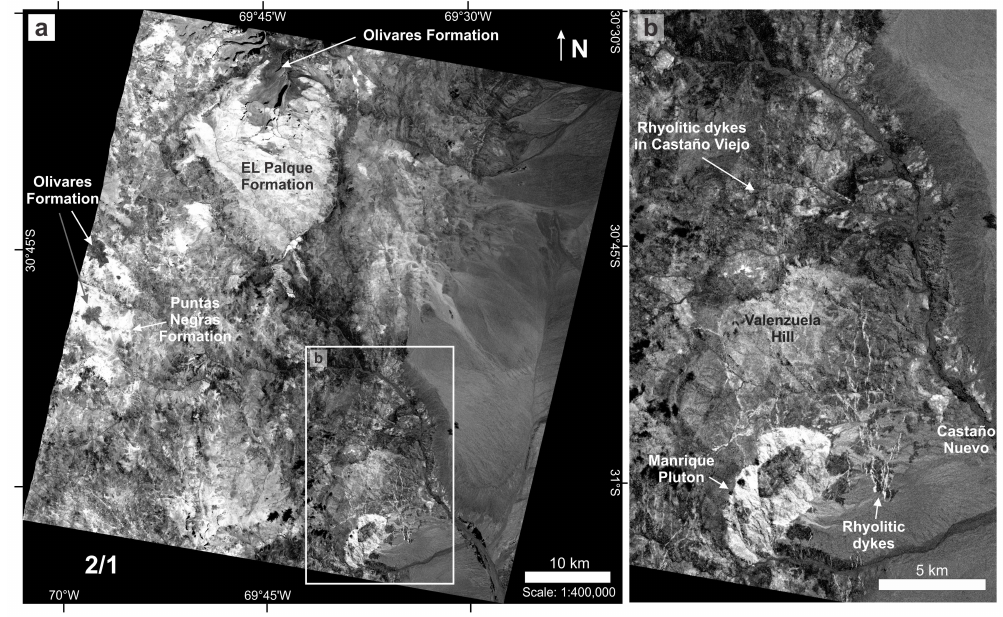
Figure 6. The ASTER band ratio 2/1 detects pixels with intense Fe 3+ absorption [58]. ( a ) In the study area, it discriminates lithology types as it highlights felsic units in bright tones and mafic to intermediate rocks in dark shades. ( b ) The Castaño area: The Manrique Pluton and particularly the rhyolitic dykes are